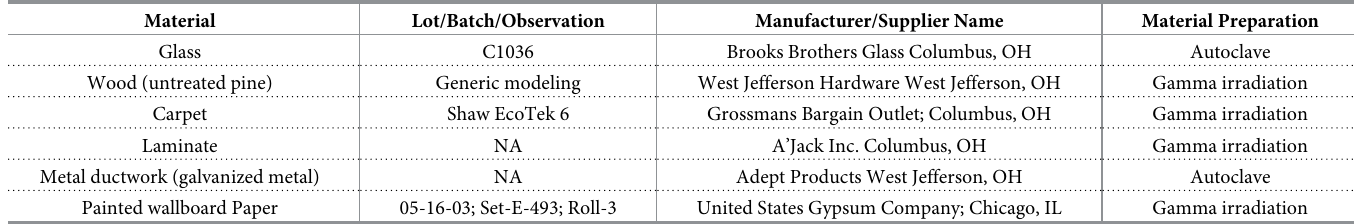
Table 1. Information on materials used for test